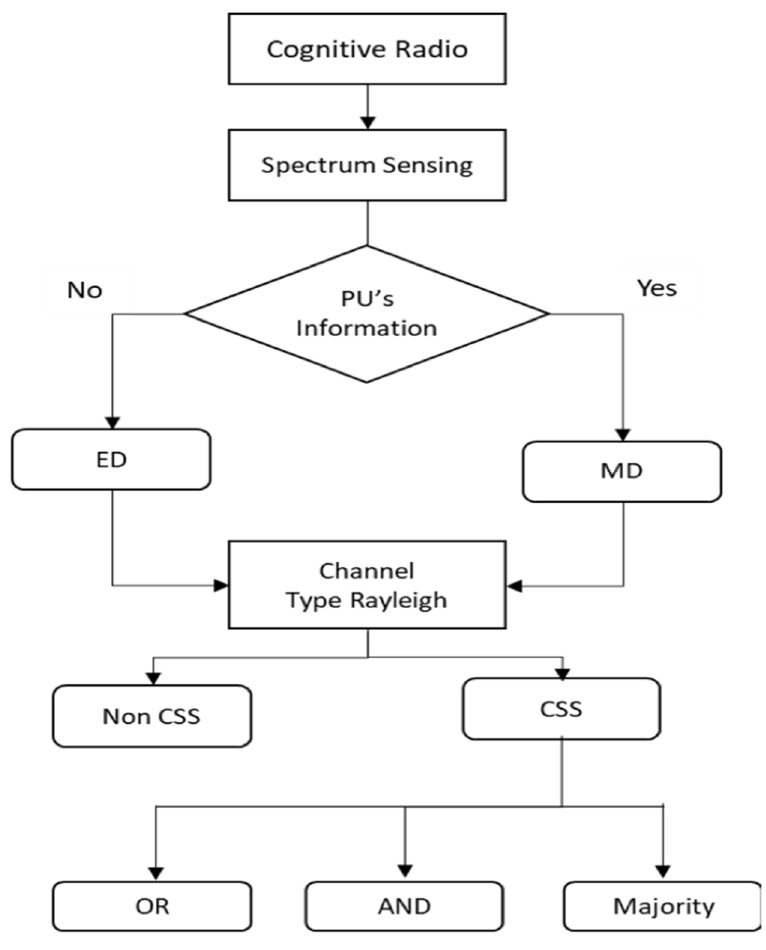
Figure 3. Proposed hybrid detector model .